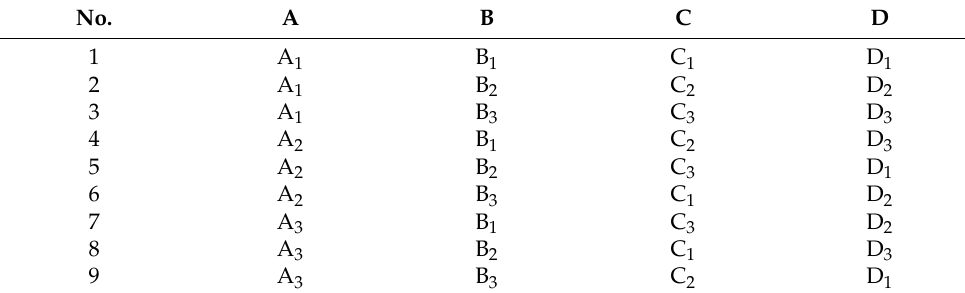
Table 1. Typical orthogonal design table L9(3 4